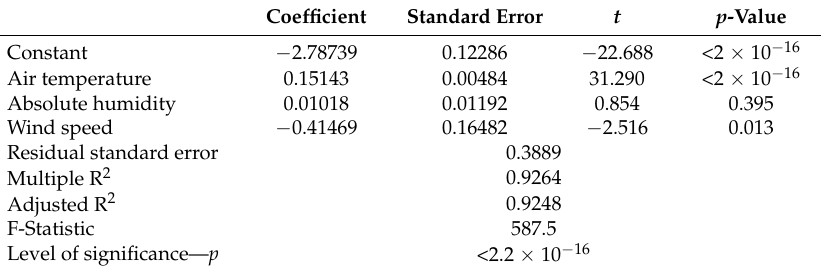
Table 5. Results of the regression performed with the variable absolute air humidity.